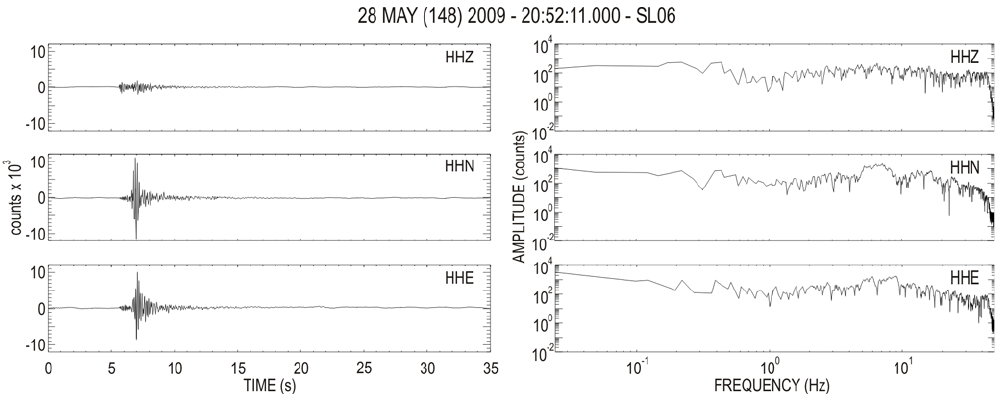
Fig. 3. Seismograms and amplitude spectra of a typical single-station event recorded by the three-component station SL06. Date and time above refer to starting point of the seismic trace. For this event, a source–station distance of about 8km can be estimated from an S – P time of 1s.